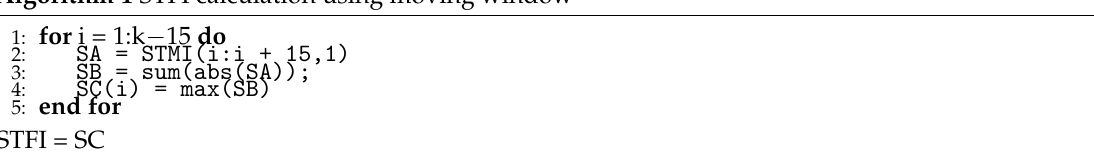
Algorithm 1 STFI calculation using moving